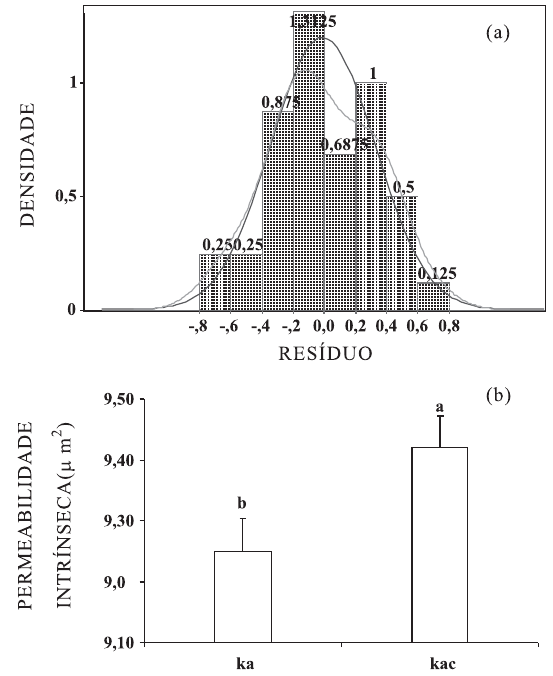
Figura 5. Histograma de distribuição de densidade de probabilidade dos dados (curva cinza) e de uma distribuição normal (a) e permeabilidades do solo ao ar sem (ka) e com (kac) a correção da viscosidade dinâmica do ar em função da temperatura. Médias comparadas pelo teste t (0,05 p.)